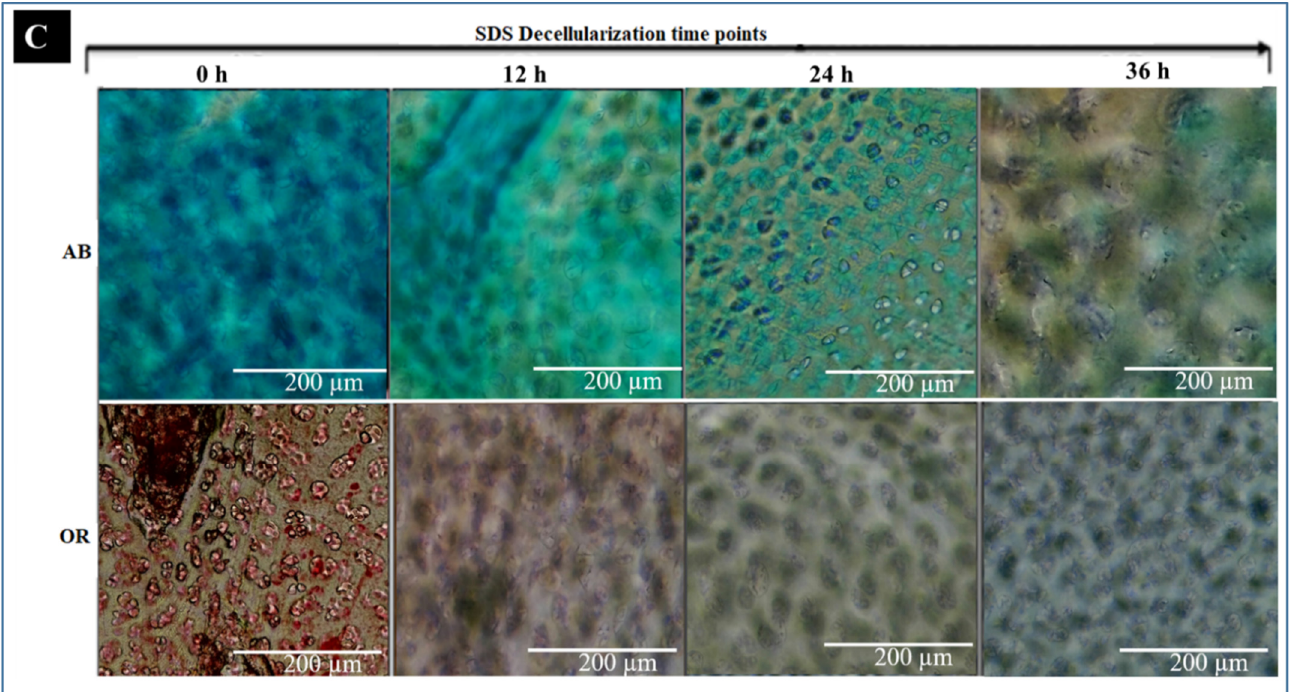
Figure 7. ( A ) Quantitative analysis of lipids in decellularized cartilage tissue. ( n = 4, * p -value = 0.04864, ** p -value = 0.00283). ( B ) Quantitative analysis of sulfate GAG (sGAG) in decellularized cartilage tissue. ( A ) Data are shown as mean ± SEM. ( n = 4, * p -value = 0.02458, ** p -value = 0.5408). ( C ) Comparative histochemical analysis of proteoglycan and tissue lipid content of decellularized avian articular cartilage. Alcian blue staining (AB). Oil red staining (OR).